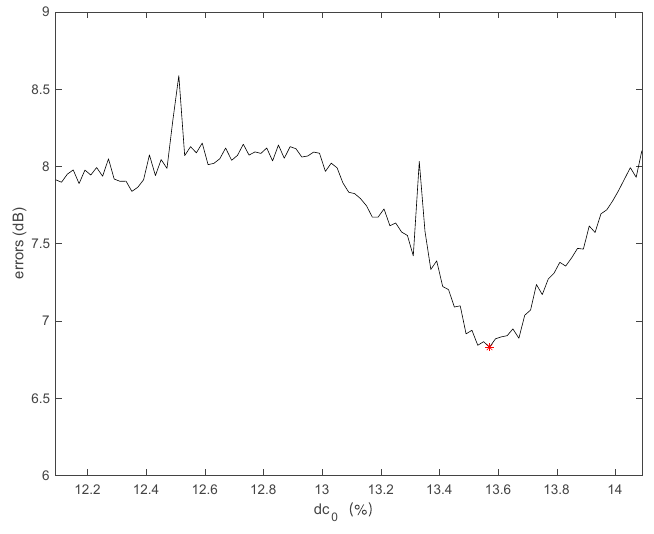
Figure 15. The errors curve under different dc 0 .